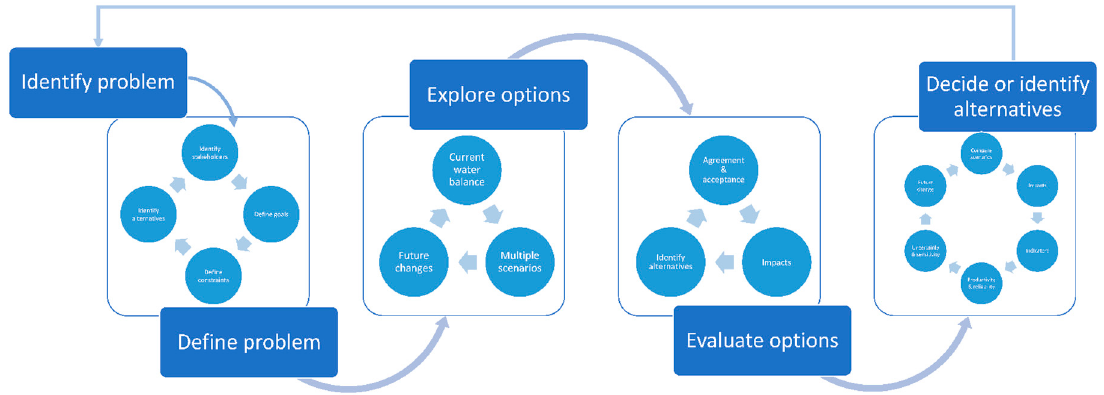
Figure 4. Framework for stakeholder engagement and collaboration on water-related issues and projects using digital platforms.